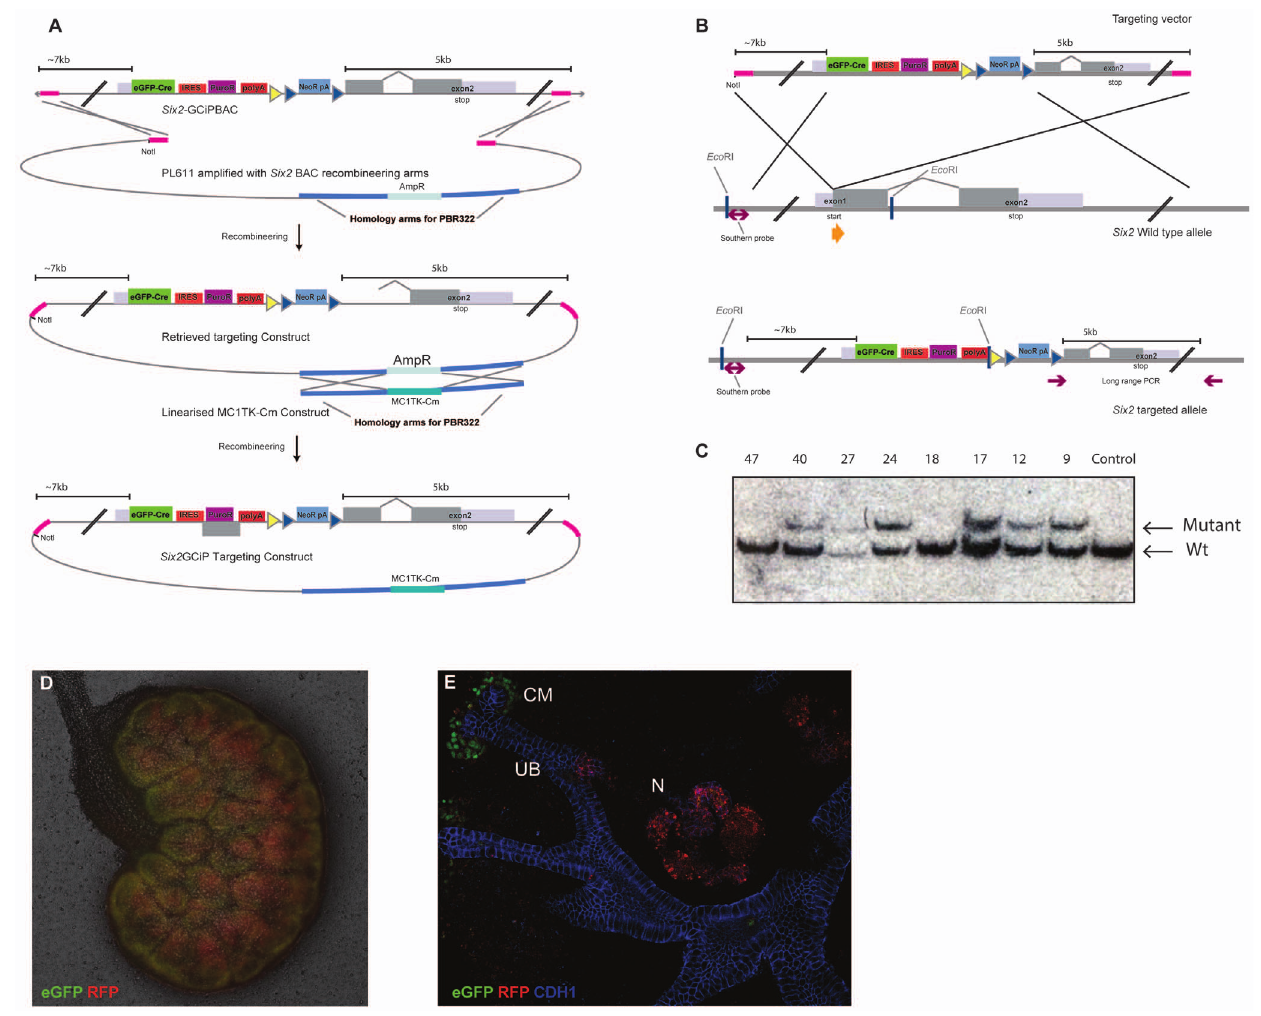
Figure 4. The Six2 + /GCiP allele based on the pMULTIrec system. A. Retrival of the Six2 -GCIP targeting vector. B. Targeting of the Six2 locus. C. Confirmation of correct targeting of the Six2 locus (restriction enzyme and probe indicated in figure 4B). D. Six2 + /GCiP Rosa26 tdRFP kidney in culture showing GFP and RFP signals. E. Six2 + /GCiP Rosa26 tdRFP kidney in culture showing GFP and RFP signals and Cdh1 antibody staining. CM: cap mesenchyme; UB: ureteric bud; N: